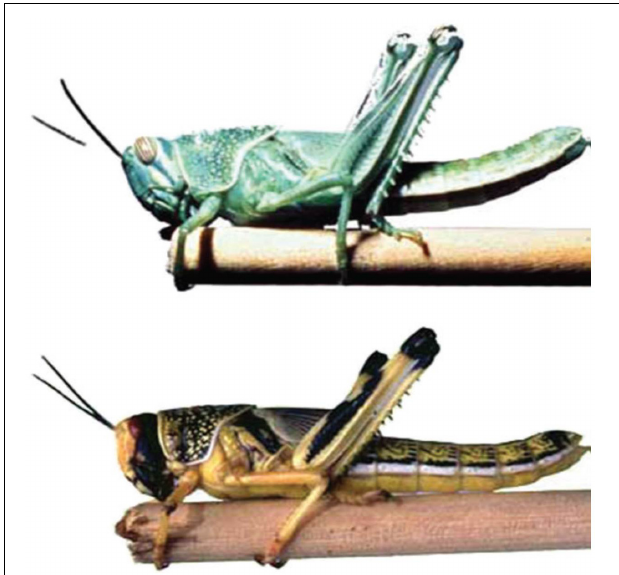
FIGURE 3 | Solitary and gregarious morphs of the desert locust. This dramatic and rapidly produced difference in both appearance and behavior is triggered by increased social stimulation. Reprinted with permission from AAAS (Anstey et al.,